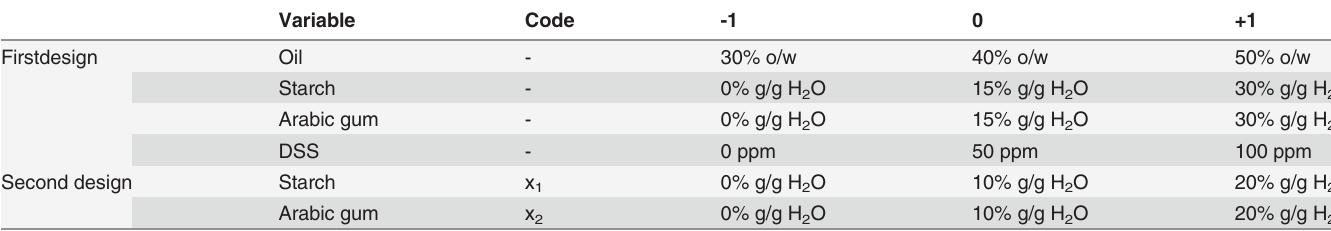
Table 1. Range of the independent variables values in the sequential experimental design